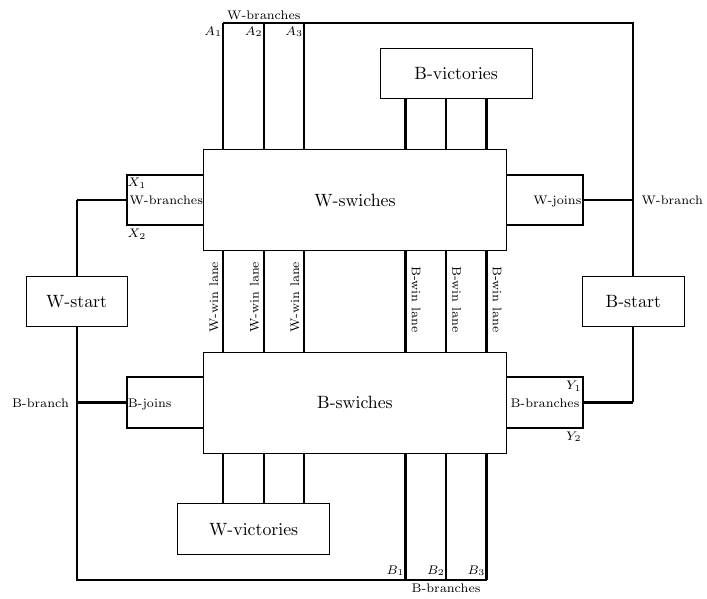
Figure 107. Custodian capture game for G 2